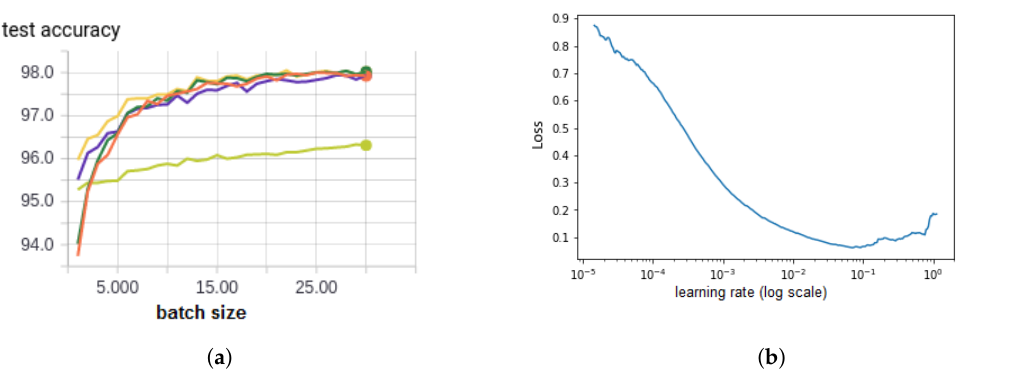
Figure 14. Effect of ( a ) batch size and ( b ) learning rate on